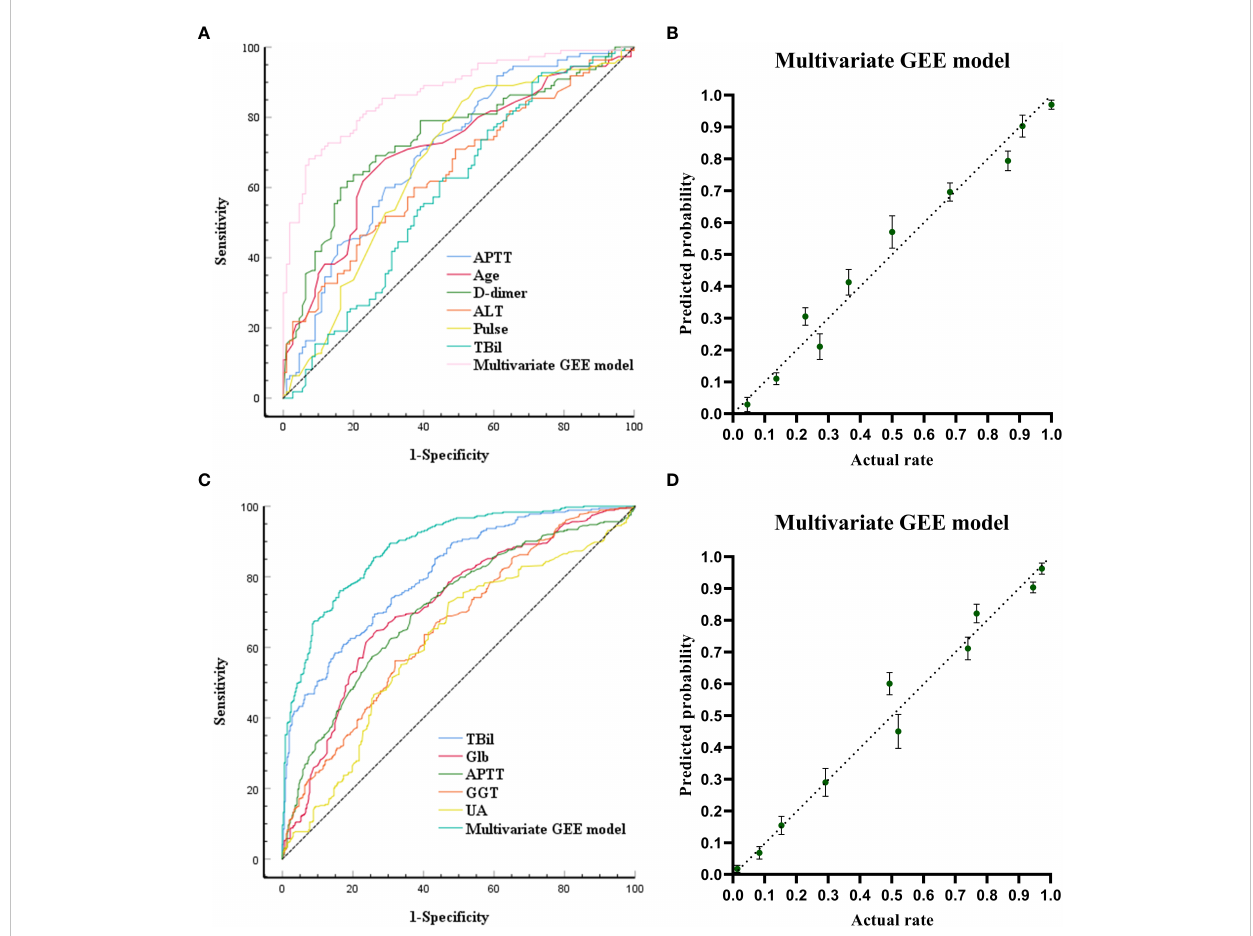
FIGURE 1 Receiving Operating Characteristic Curve and calibration plots for the baseline models (models built at the time of admission) and the pre-models (models built before ALSS treatment) to predict in-hospital outcomes. (A) ROC curve analyses for the capability of APTT, AGE, D-dimer, ALT, pulse, TB at admission and the multivariate generalized estimating equation (GEE) model to predict in-hospital outcomes. (B) Calibration plots for the baseline multivariate models to predict in-hospital outcomes. (C) ROC curve analyses for the capability of TB, globulin, APTT, GGT, UA before ALSS and the multivariate generalized estimating equation (GEE) model to predict in-hospital outcomes. (D) Calibration plots for the pre- multivariate models to predict in-hospital